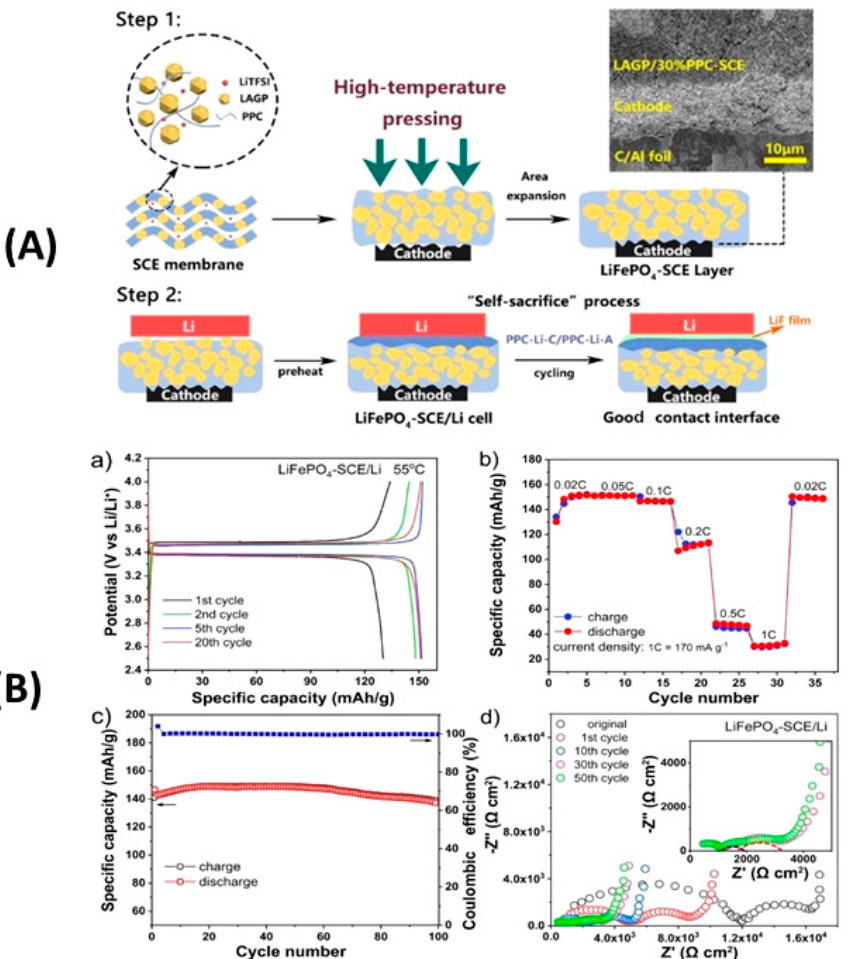
Figure 33. ( A ) Schematics of all-solid-state battery assembly. Step 1 illustrates the hot press progress of the LiFePO 4 cathode and LAGP/30%-SCE electrolyte (where LAGP and SCE denote Li 1.5 Al 0.5 Ge 1.5 (PO 4 ) 3 and solid composite electrode, respectively) and scanning electron micrograph of the cross-section of the contact interface. Step 2 depicts the preactivation of the LiFePO 4 -SCE||Li cell. ( B ) Voltage profiles of the LiFePO 4 -SCE||Li cell at the current rate of 0.02C ( a ). Rate performance of the LiFePO 4 -SCE/Li cells at current rates in the range of 0.02–1C ( b ). Cycling stability of the LiFePO 4 -SCE/Li cell at the current rate of 0.05 C and 55 °C ( c ). Nyquist plots of the LiFePO 4 -SCE||Li cells before and after different cycles, and magnified areas of the plots in the inset ( d ). Reproduced with permission from [430]. Copyright 2019 American Chemical Society.